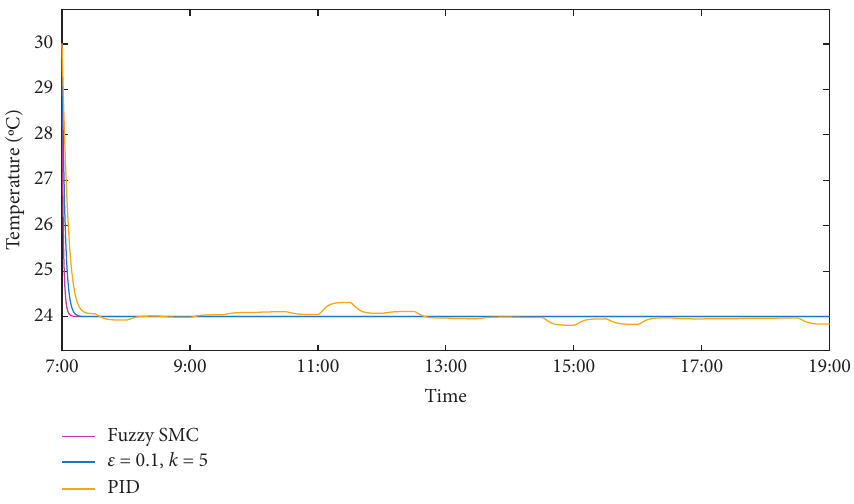
Figure 12: Temperature response curve comparison.